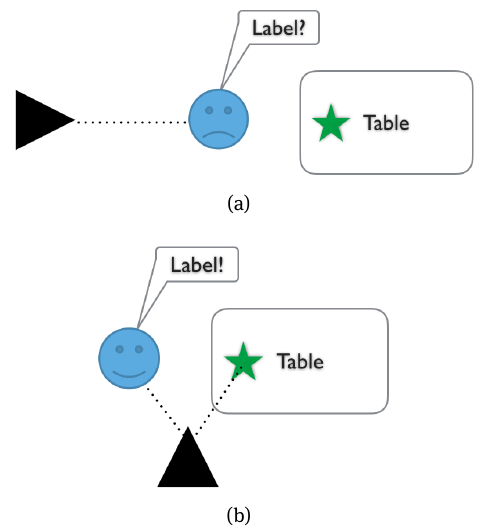
Figure 14: a) A common problem encountered during person fol- lowing for interactive labeling. The user wants to label an object on the table, however, the robot does not know the user’s intention and stays behind at a fixed distance to the user; b) Our solution is for the robot to navigate to a location that gives the robot a better chance to observe the user and the object